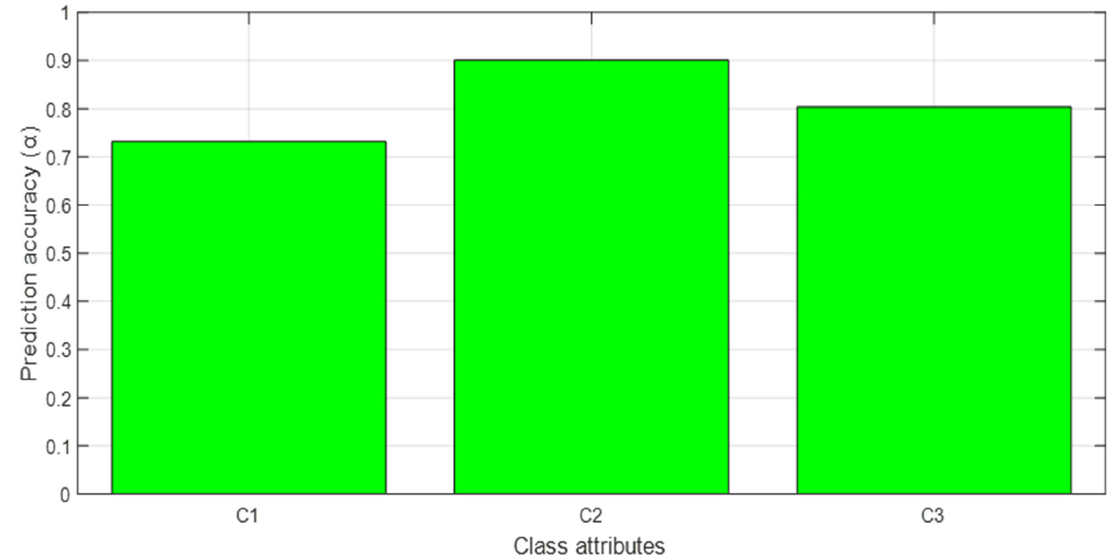
Figure 3. Visualization of prediction accuracy, 𝑎 , for all the three class attributes.